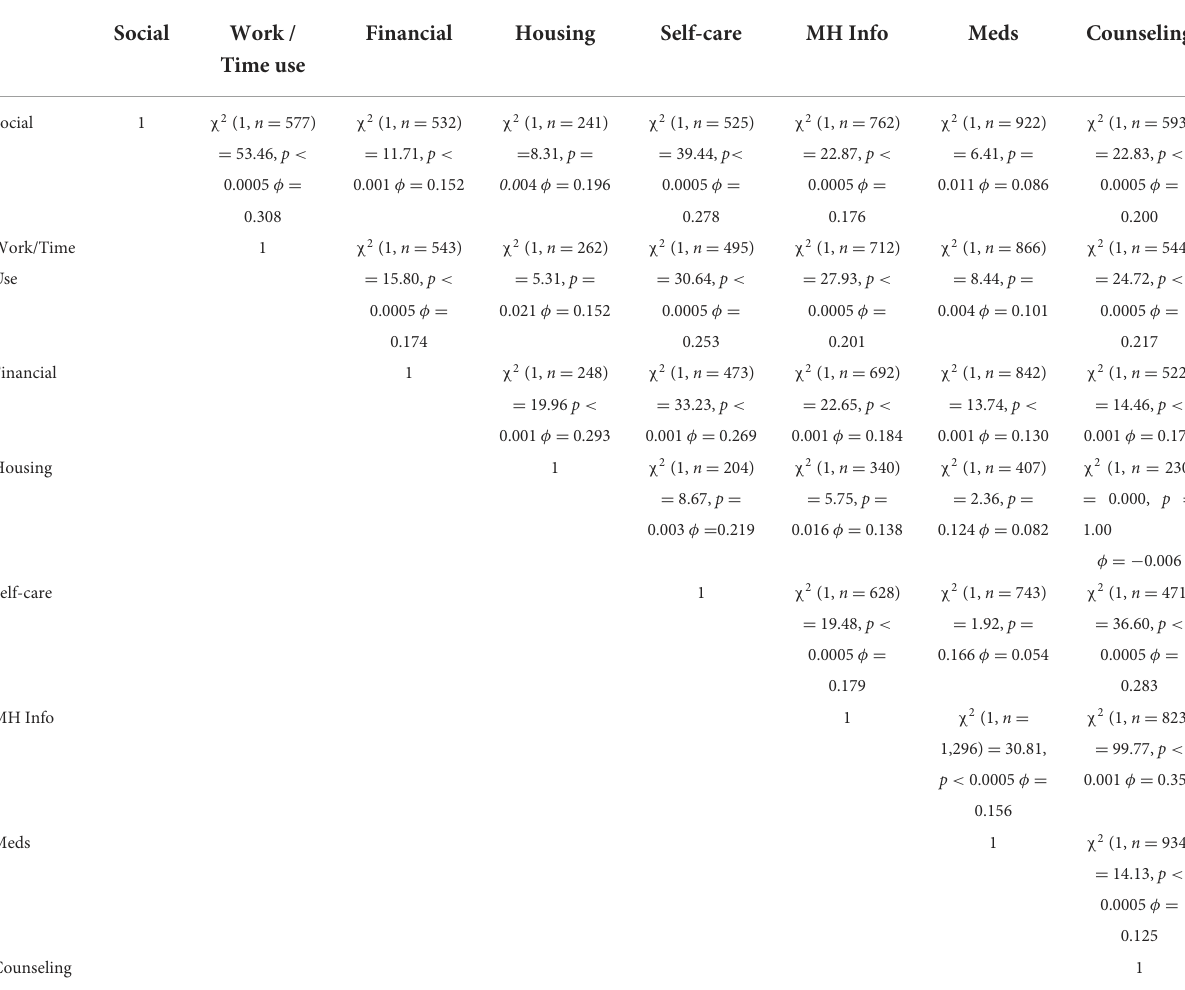
TABLE 2 Series of bivariate analyses (Chi Square with Yates Continuity Correction: X 2 ) displaying the relationships between the PNCQ domains. Social Work / Financial Housing Self-care MH Time use